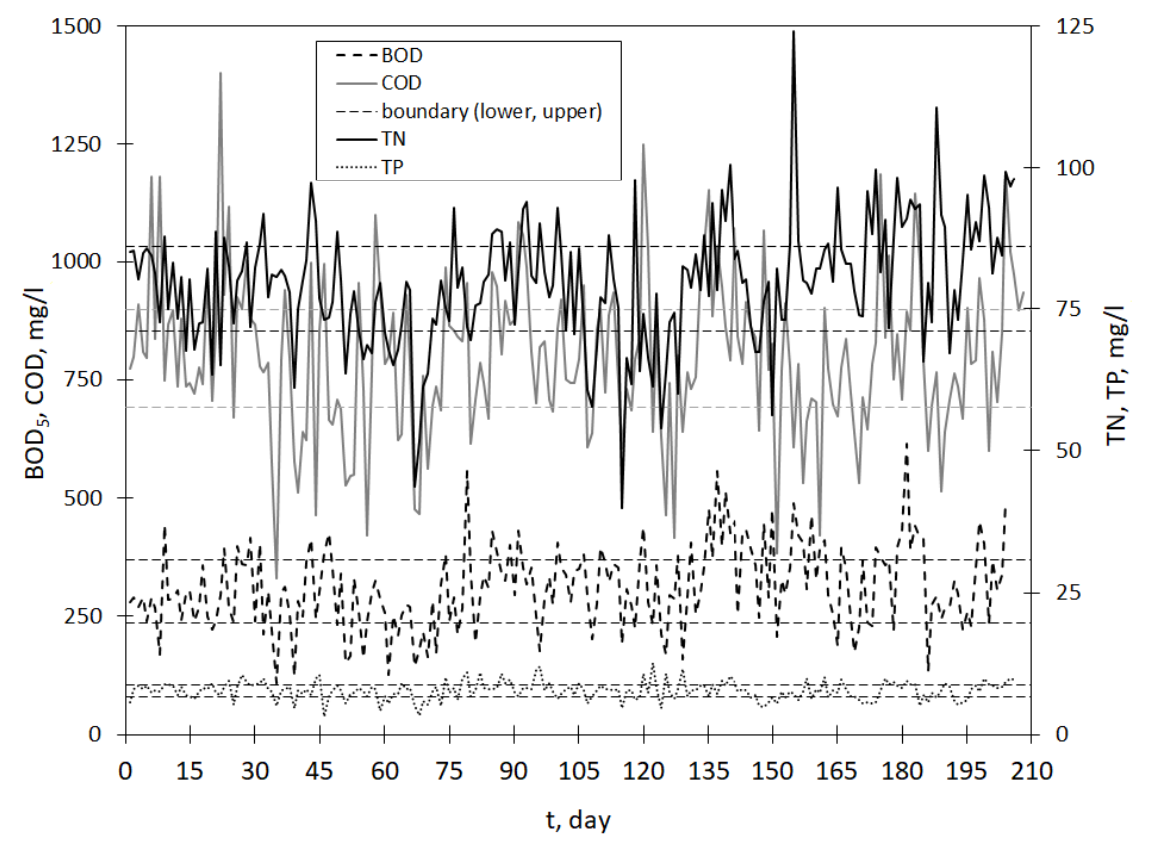
Figure 3. Variability of BOD 5 , COD , TN , and TP values, taking into account the limit values constituting the basis for their division into classes (reduced, typical, increased values).